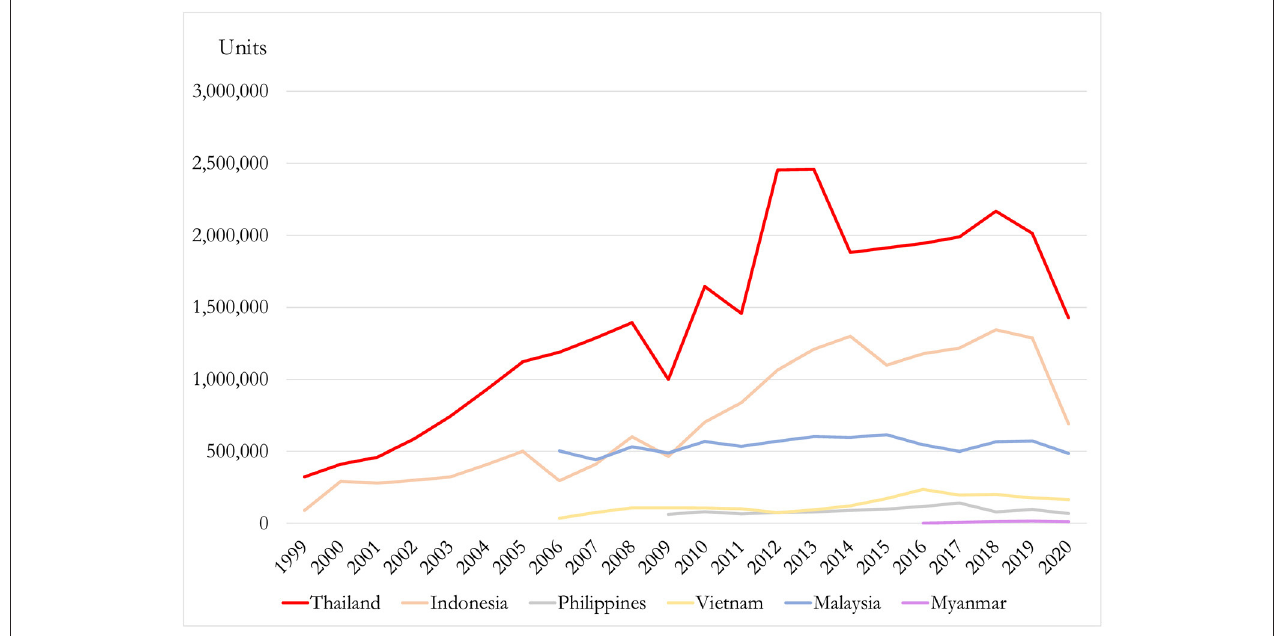
FIGURE 4 | Yearly automobile production in ASEAN countries (Retrieved from AAF and OICA on July 15,